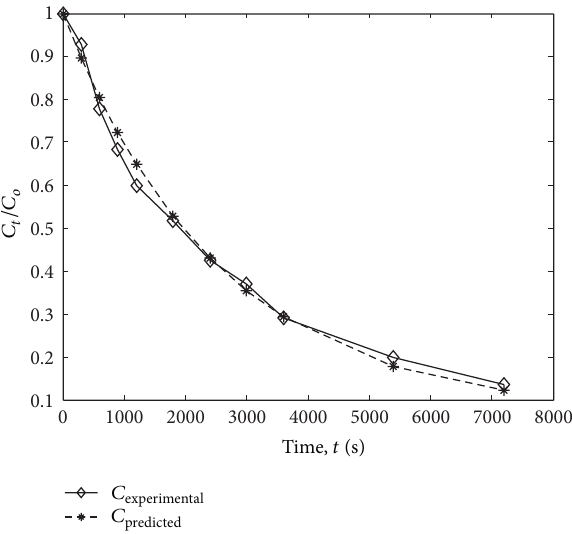
Figure 20: Variation of dimensionless bulk concentration of MB with time for initial bulk concentration of 200 mg/L.